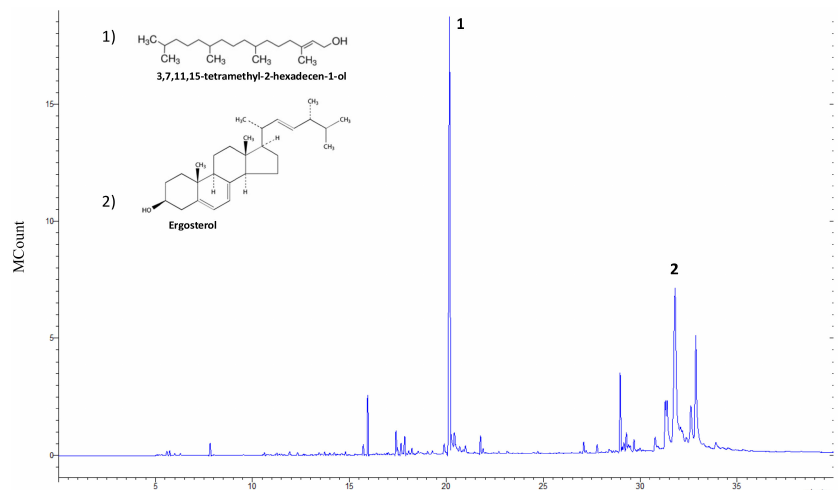
Figure 1. Total ion chromatogram of the unsaponified fraction (UP) of Chlorella sorokiniana and molecular structures of the predominant constituents.